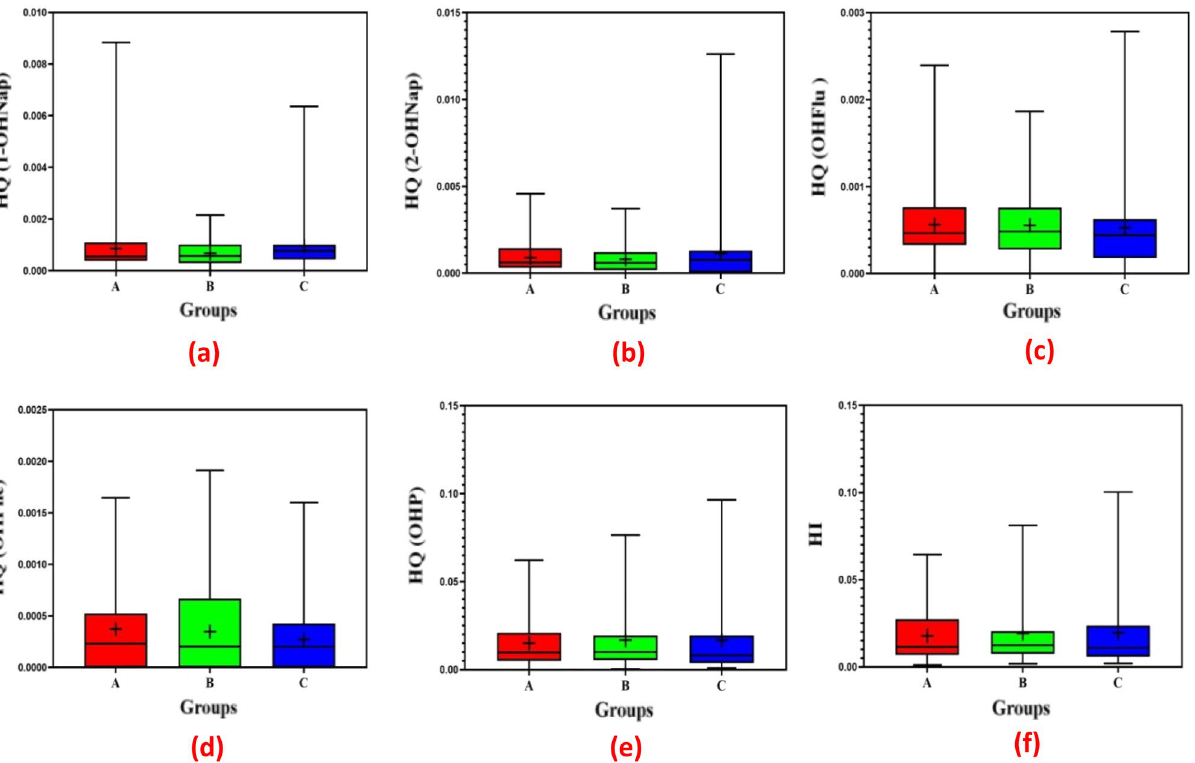
Figure 4. HQ i for PAH metabolites (( a ) 1-OHNap, ( b ) 2-OHNap, ( c ) 2-OHFlu, ( d ) 9-OHPhe, and ( e ) 1-OHP) and ( f )